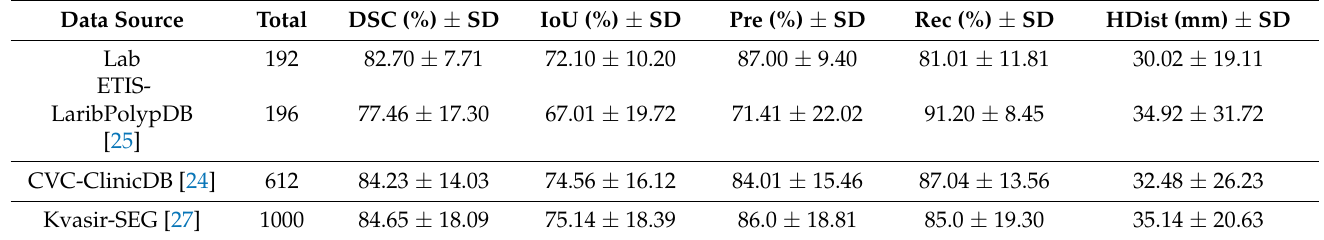
Table 1. Lesion segmentation comparison using the limited labeled GI